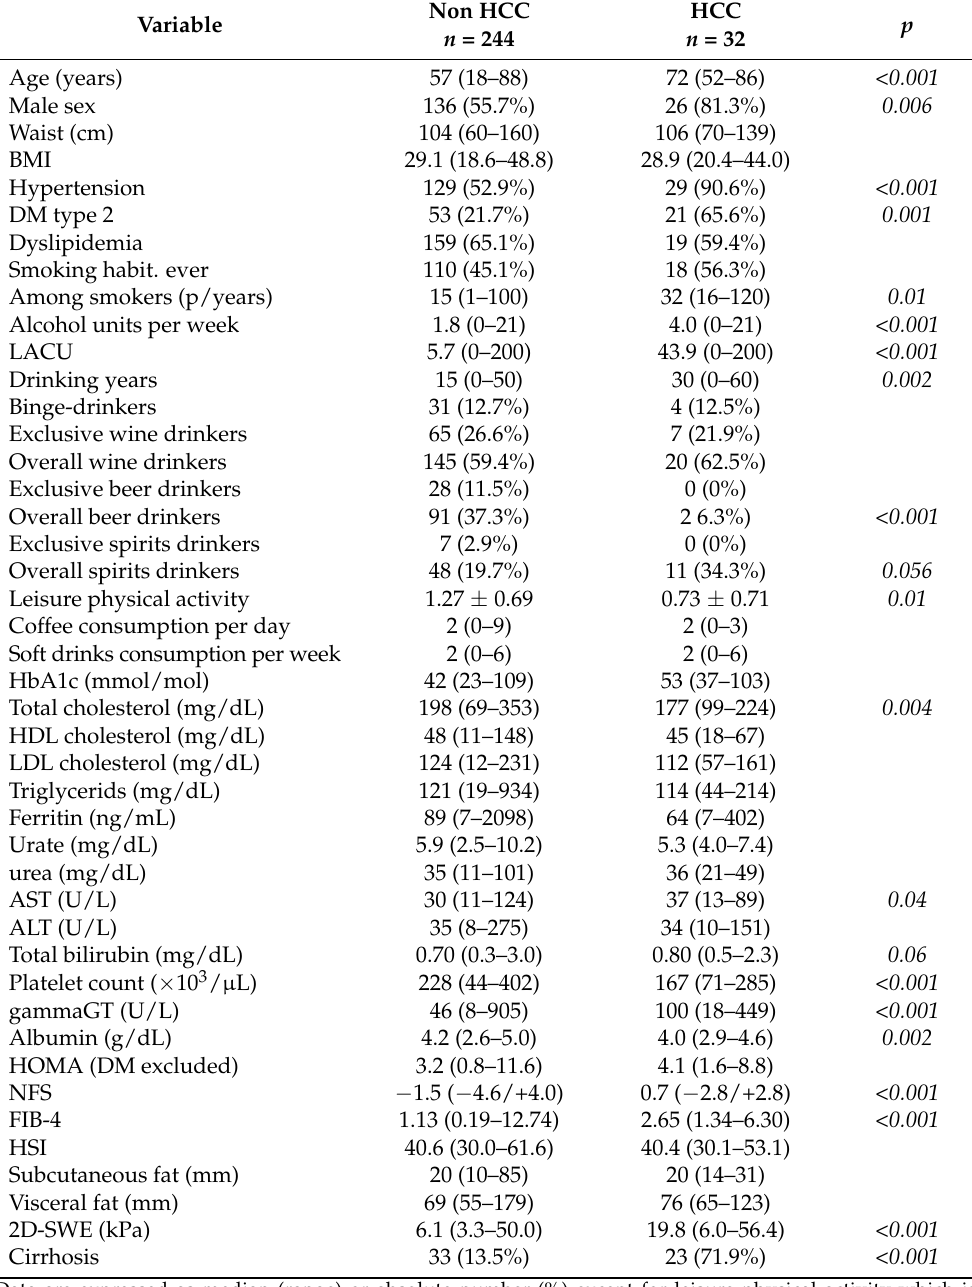
Table 7. Patient characteristics according to the presence of hepatocellular carcinoma